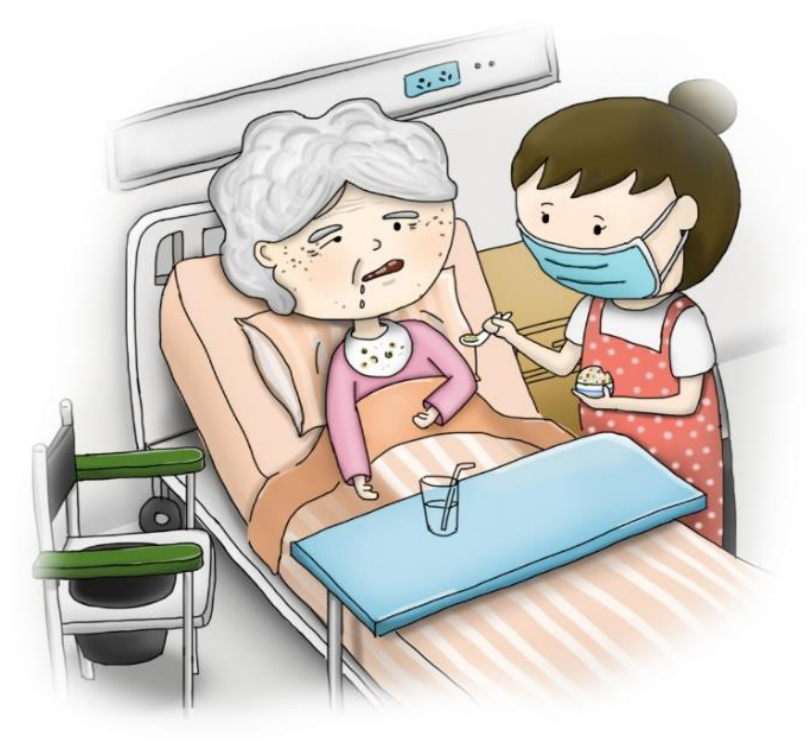
Figure 5. Severe stroke with a slight chance of recovery.